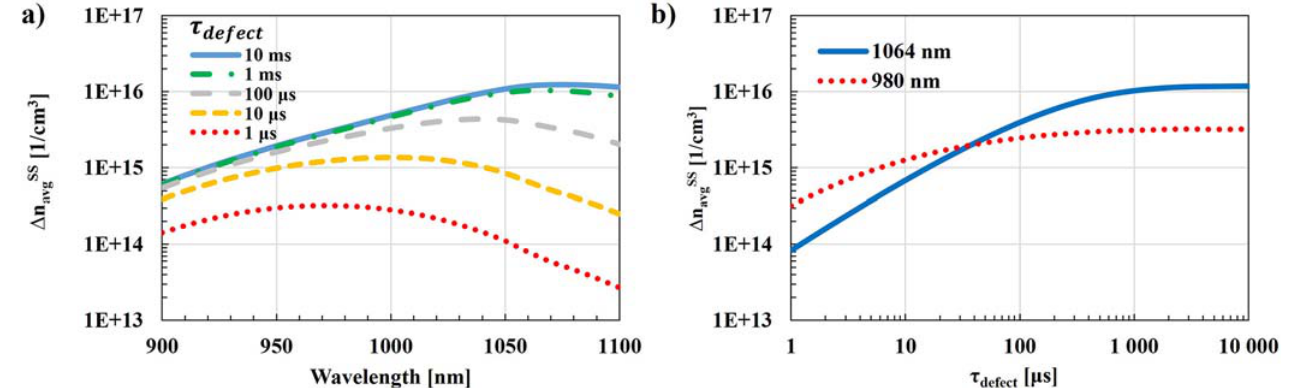
Fig. 2. (a) Steady-state injection levels, D n SS , versus excitation wavelength for samples with different defect related bulk lifetimes. avg (b) Considering other factors as well, 1064nm is proposed for detailed comparison with the earlier standard 980nm. Parameters: S front =10 6 cm/s, F =2 (cid:3) 10 19 cm (cid:1) 2 s (cid:1) 1 , p-type doping N dop =10 16 cm (cid:1)